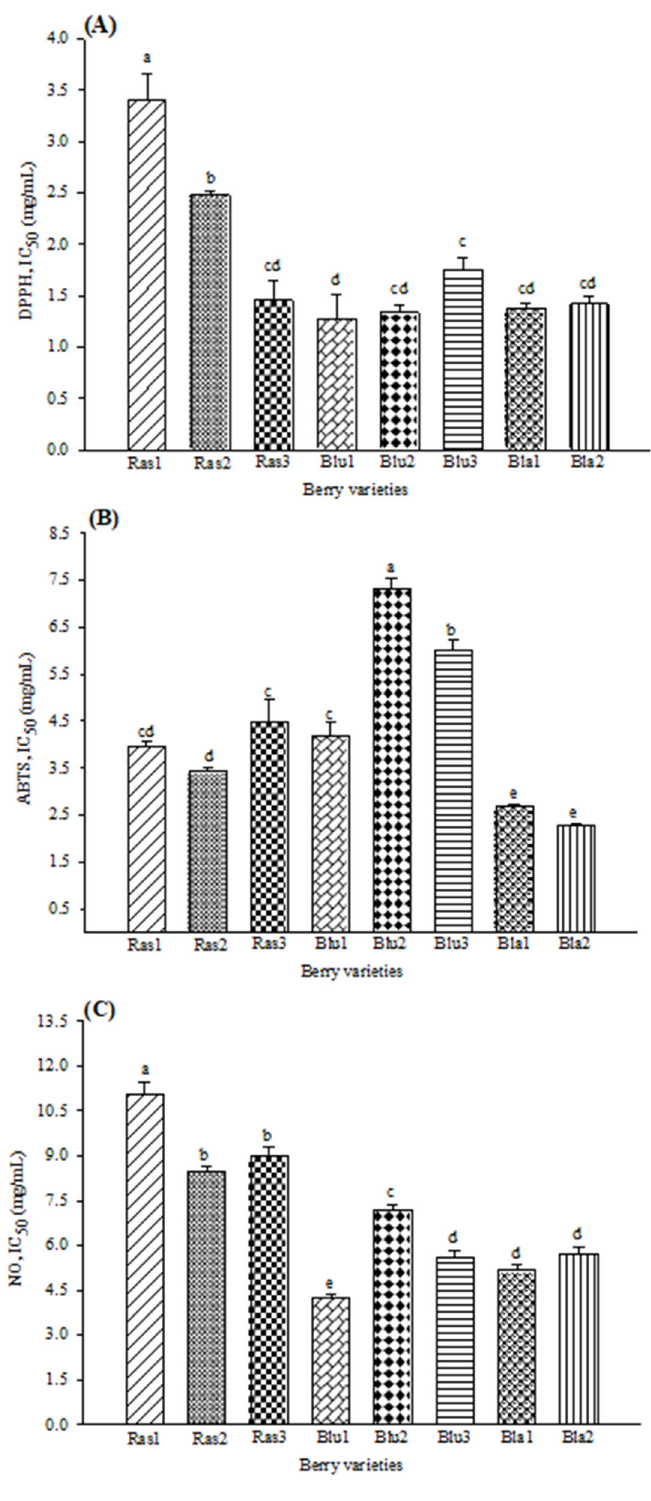
Figure 1. Antioxidant activity in eight varieties of Mexican berries, showing the scavenging of ( A ) DPPH radical, ( B ) ABTS radical and ( C ) nitric oxide. Data represent the mean ± SD from three independent replicates. Different letters (a–e) indicate significant difference ( p < 0.05) according to Tukey’s test. DPPH: 2,2 ‐ diphenyl ‐ 1 ‐ picrylhydrazyl; ABTS: 2,2 ′‐ azino ‐ bis 3 ‐ ethylbenzothiazoline ‐ 6 ‐ sulphonic acid; NO: nitric oxide. IC50 values (mg/mL).